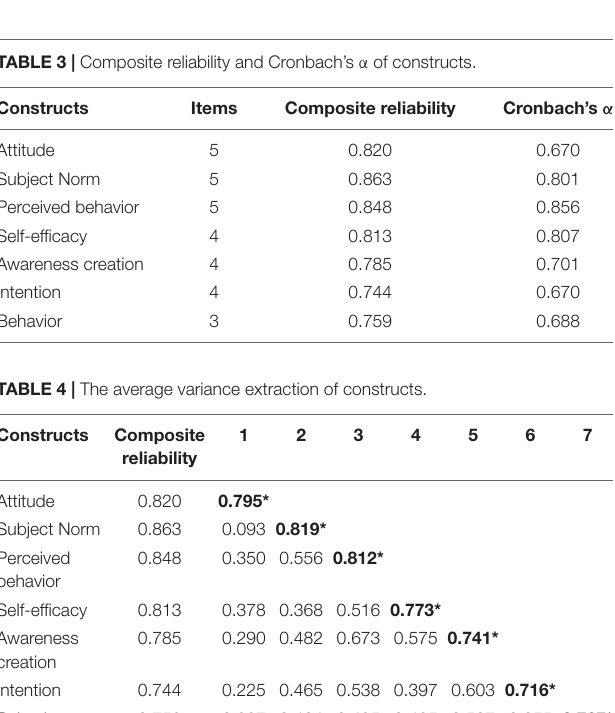
*Diagonal elements are the square roots of average variance extracted (AVE). The square root of the AVE for each major construct was larger than the inter-construct